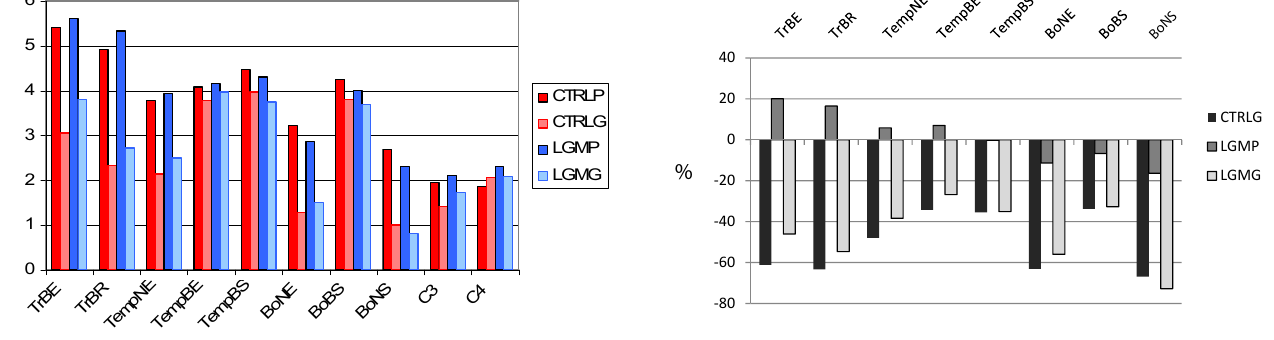
Fig. 10. Global mean annual maximum leaf area index (LAI) (m 2 m − 2 ). The LAI is averaged on the grid-cells where the frac- tion of the PFT exceeds 1%. Abbreviations: see Table 1 for the PFTs and Table 2 for the simulations.